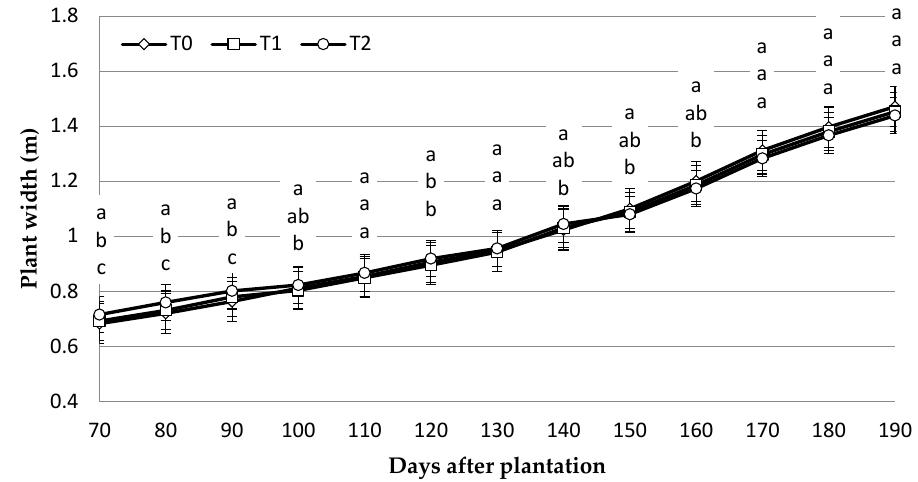
Figure 2. Plant width evolution according to the cuttings type used for the artichoke vegetative propagation. Within the same period, data were analyzed by ANOVA and values with no letter in common are significantly different at p < 0.05 according to Tukey HSD Test. Standard errors are reported. T0: summer ovoli; T1: spring offshoots nursery’s cuttings forced to pass a vegetative rest period by stopping irrigation; T2: spring offshoots nursery’s cuttings not forced. The monitoring of offshoot formation revealed significant differences between the treatments.